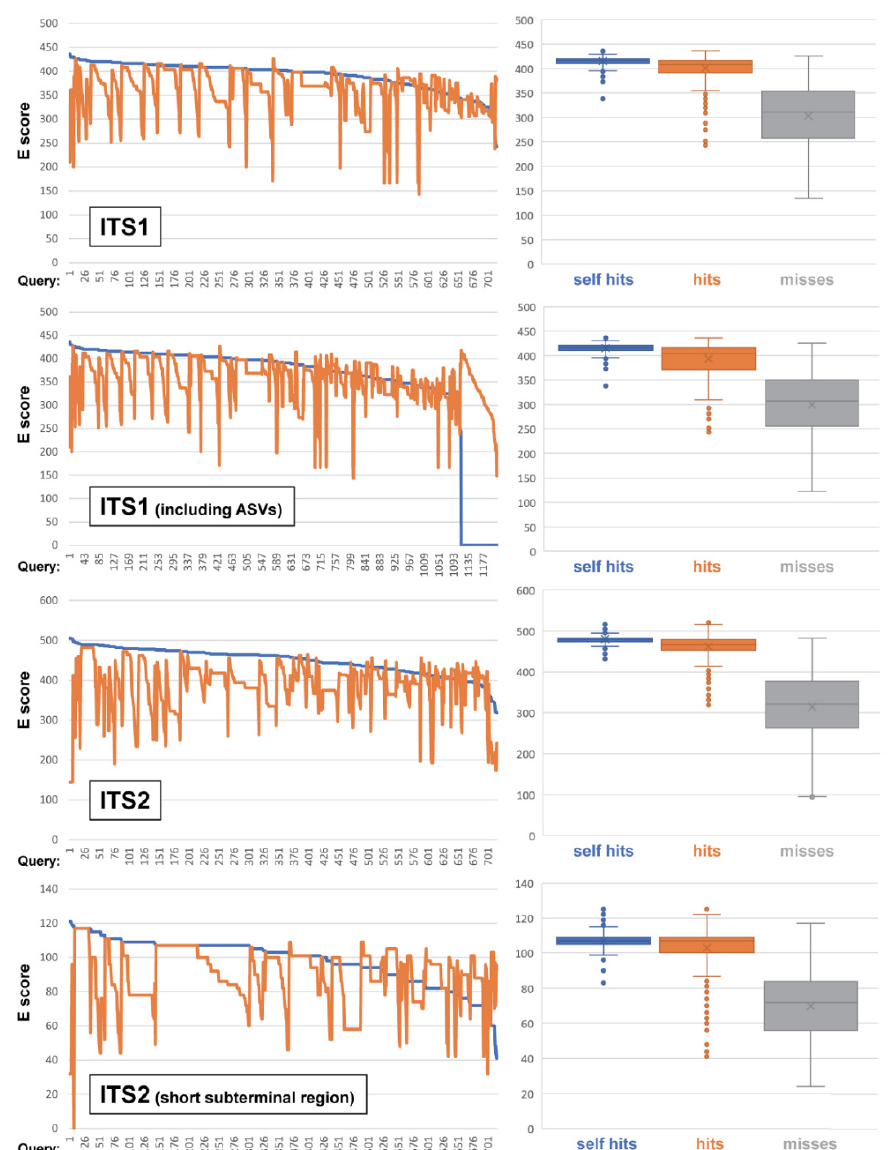
Figure 8. BLAST results for the four different scenarios (ITS1 only, ITS1 including ASVs, ITS2, and short subterminal ITS2 region). The left column of graphs shows the terminals for each subset ranked by the minimum E score for hits (blue line), as opposed by the maximum E score for misses (orange line). The right row of graphs shows the corresponding overall distribution of E scores for self ‐ hits, hits, and misses, for each subset.